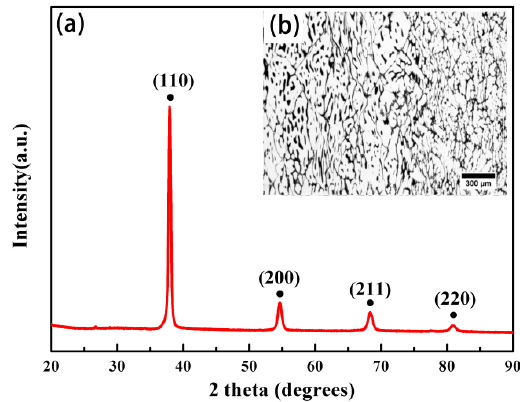
Figure 10. The microstructures of the ZrTiHfNb 0.5 Ta 0.5 alloys after being compressed at 800 °C: ( a ) XRD pattern; ( b ) metallography.